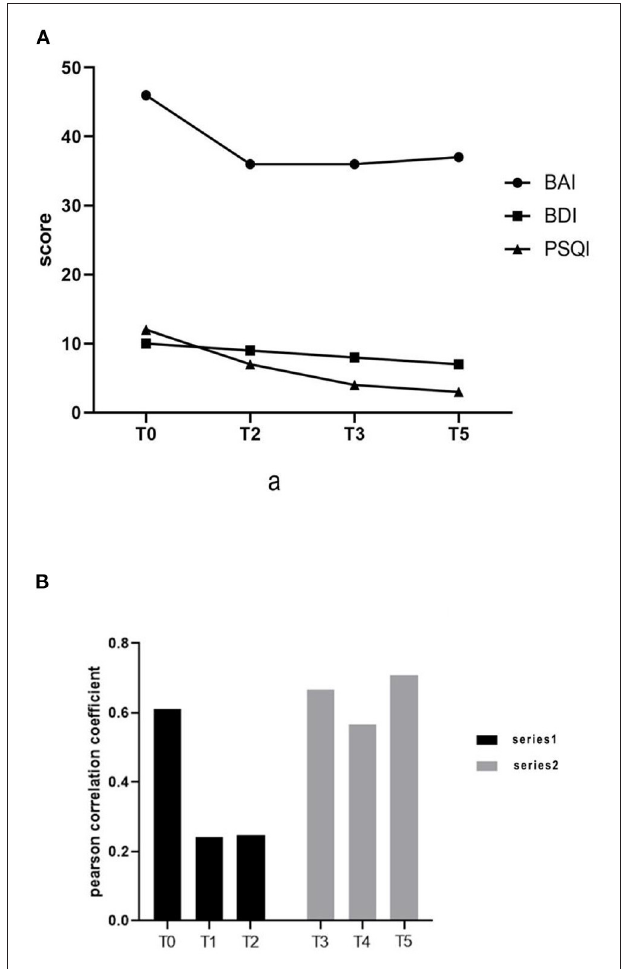
FIGURE 2 | (A) Changes in Beck Anxiety Index, Beck Depression Index, and Pittsburgh Sleep Quality Index scores. (B) Functional connection of prefrontal